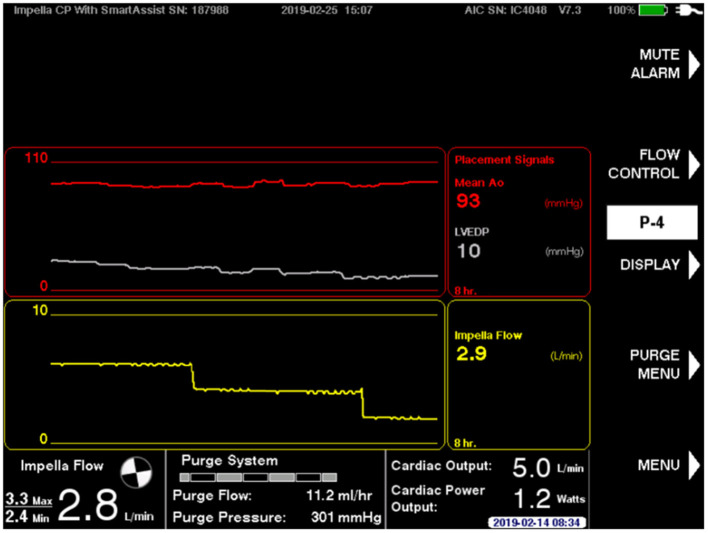
The novel Impella smart assist, displaying real-time LV end-diastolic pressure and mean arterial pressure on the Impella console.